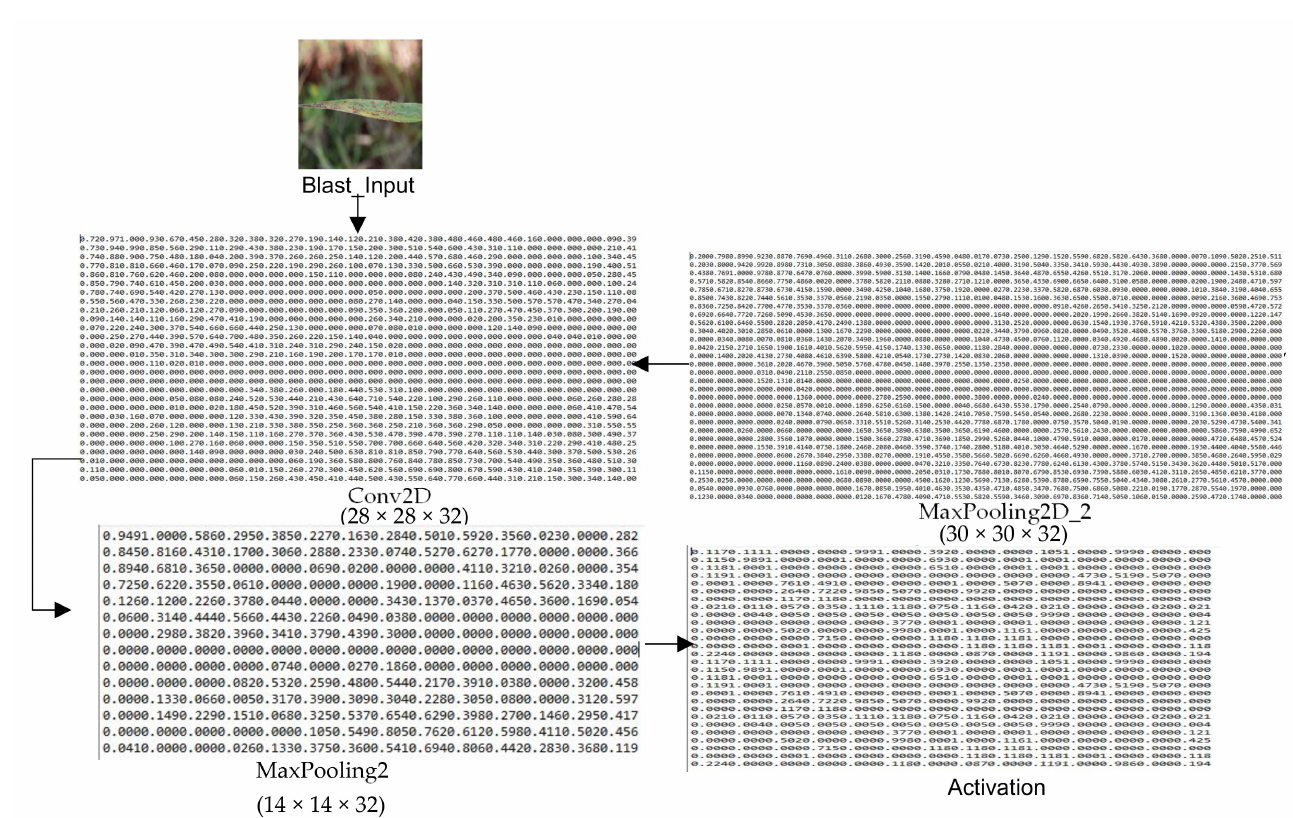
Figure 5. Output matrix of selected layers of ‘Custom-Net’